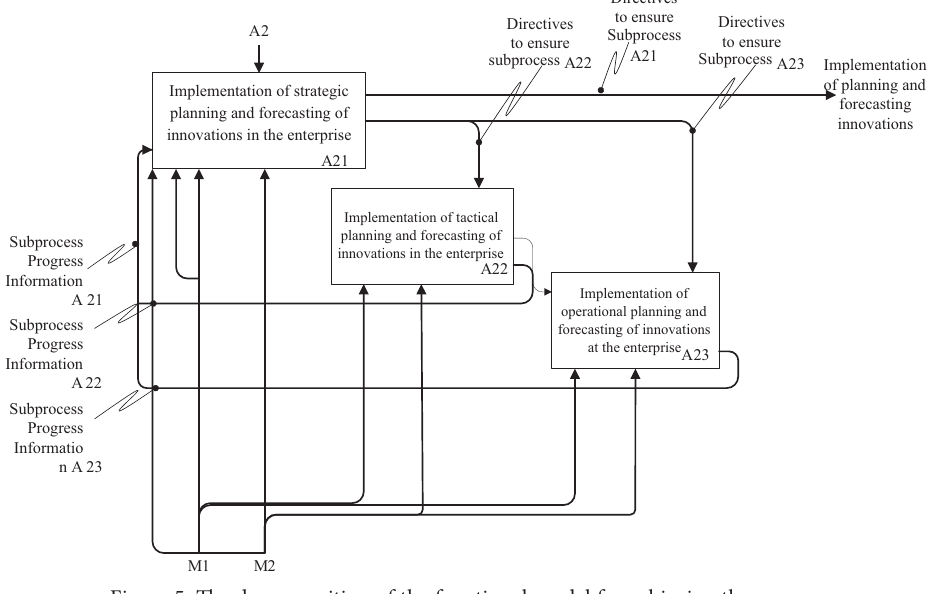
Figure 5. The decomposition of the functional model for achieving the process